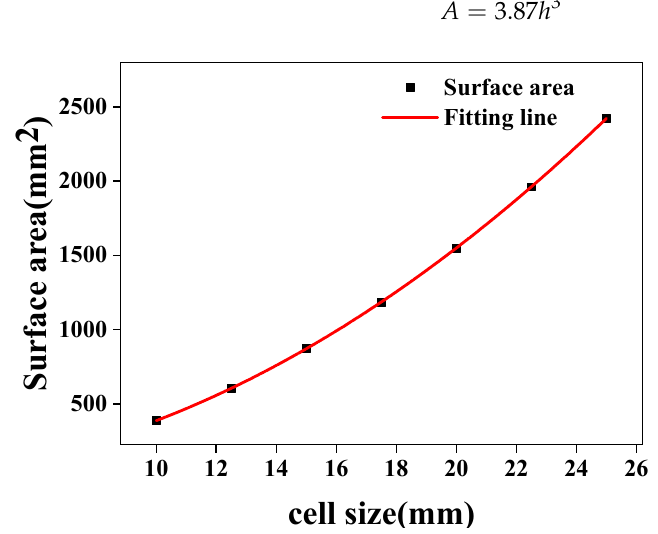
Figure 10. Relationship of cell size and surface area of the D structure.